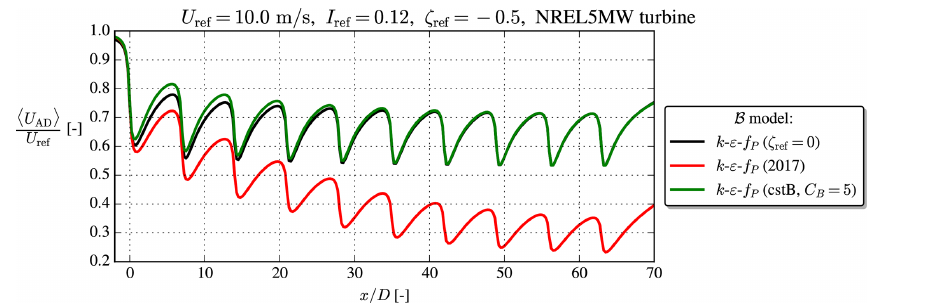
Figure A4. Aligned row of 10 turbines with inflow similar to the Case 5 of van der Laan et al. (2021).